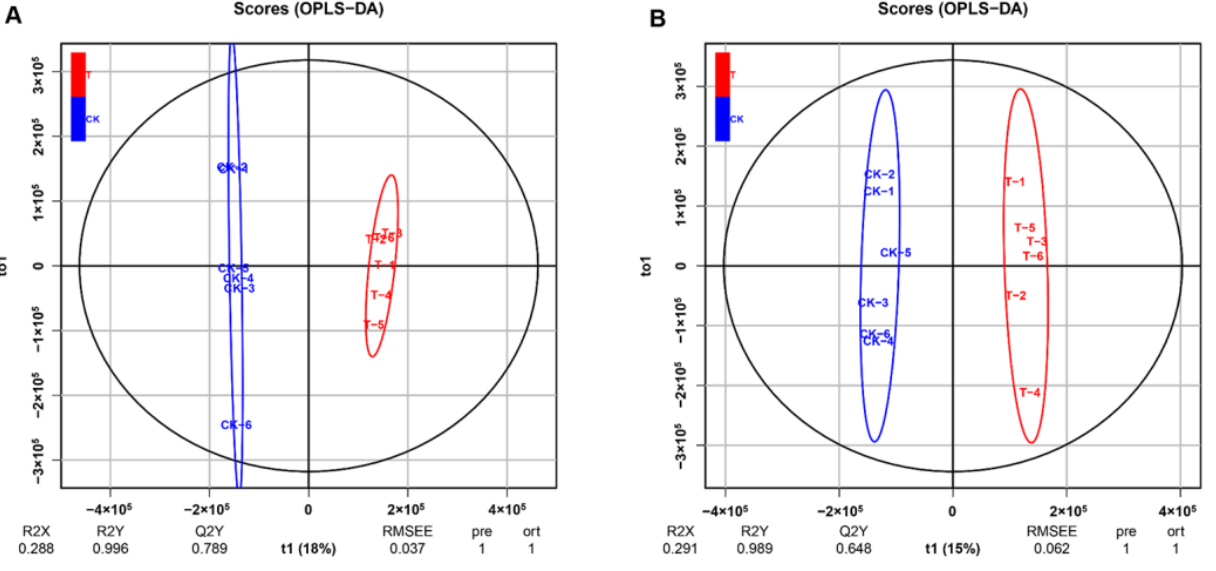
Figure 5. Multivariate statistical analysis in positive and negative ion mode. ( A ) Orthogonal projections to latent structures-discriminant analysis (OPLS-DA) in positive mode between CK-H and T-H groups. ( B ) OPLS-DA in negative mode between CK-H and T-H groups.